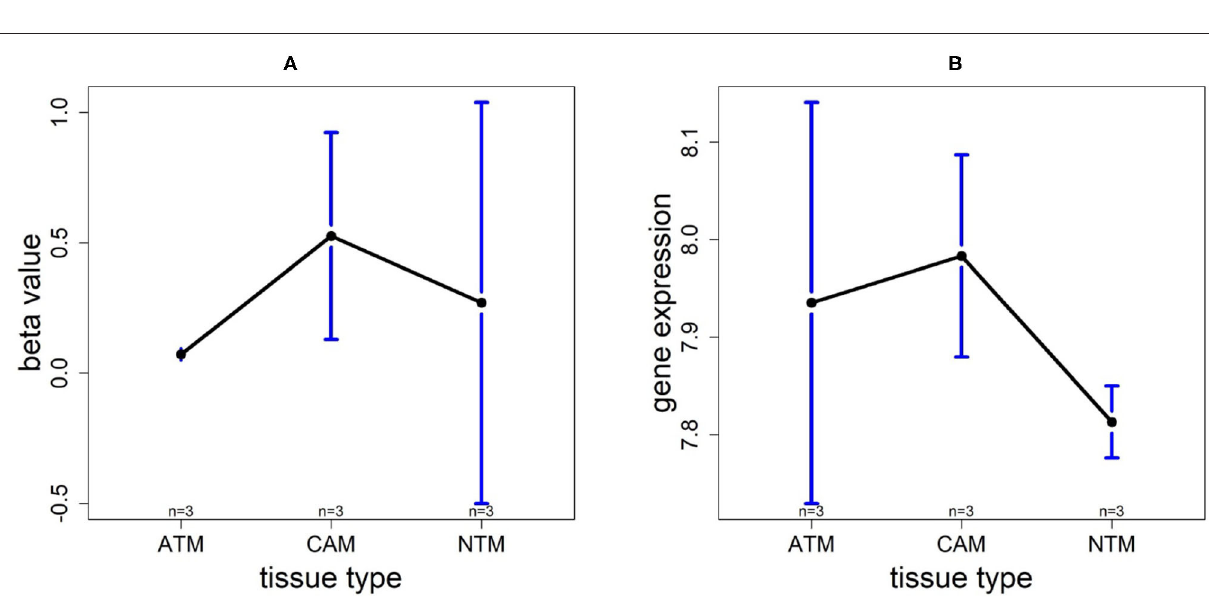
FIGURE 9 | The overall methylation and gene expression levels of the RDH13 promoter region. (A) Averaged methylation level over the three samples of gene RDH13 among tissue types from GSE97686 dataset. (B) Averaged gene expression level over the three samples of gene RDH13 among tissue types from GSE107161 dataset. The blue bars represent 95% confidence intervals. Some error bars are large as the sample size is only 3 in each tissue